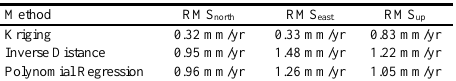
Table 4. Velocity comparison between derived and published values for Peninsular